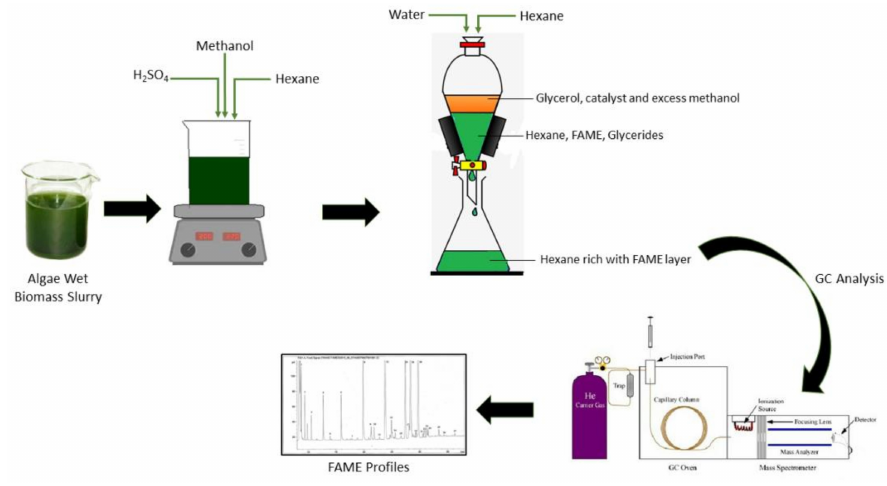
Figure 6. Microalgae fatty acids in situ